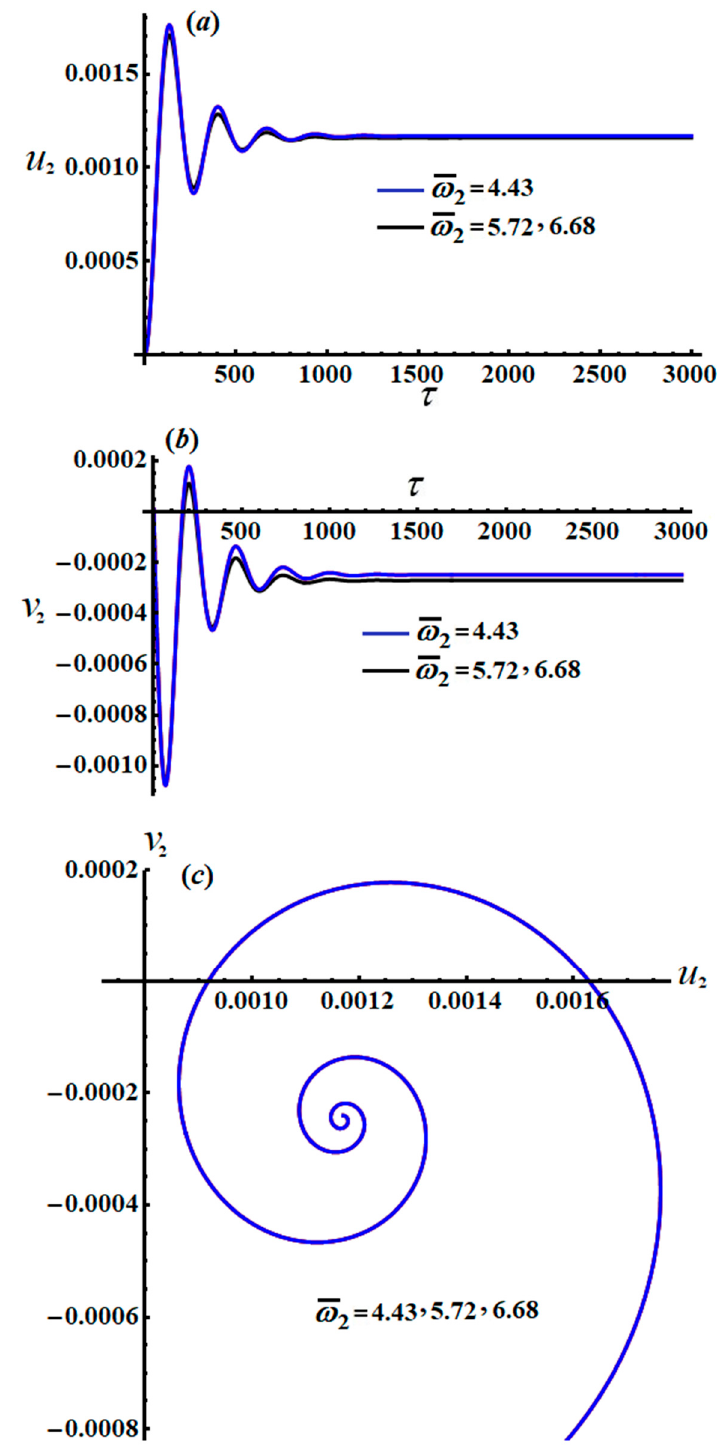
τ Figure 19. The modified amplitudes via and the projections of the modulation equation tracks Figure 19. The modified amplitudes via τ and the projections of the modulation equation tracks on ω = on the phase plane 2 2 u v : ( a )–( c ) when 2 (4.43,5.72,6.68) . the phase plane u 2 v 2 : ( a – c ) when ω 2 = ( 4.43,5.72,6.68 )